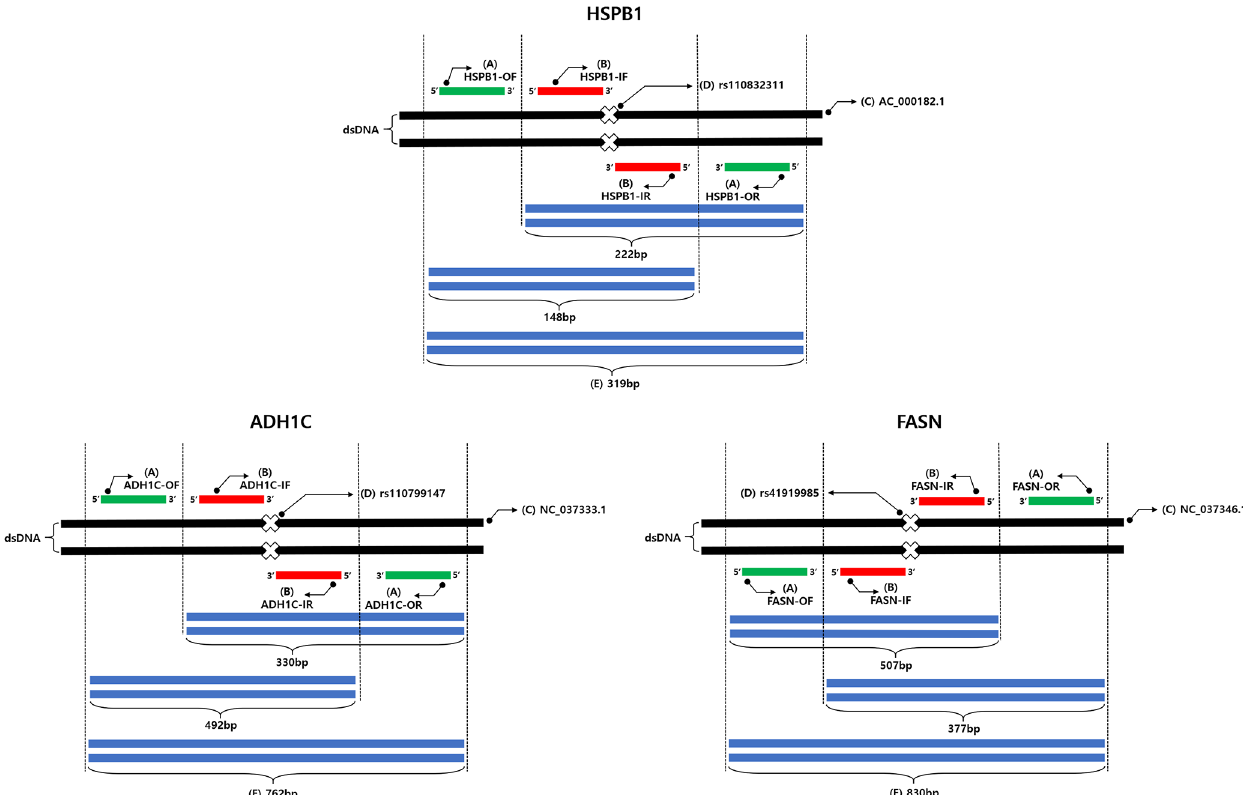
Figure 1. Schematic diagram of AS-PCR amplification and size of fragments. (A) Outer primers are indicated by green rectangles. (B) Inner primers are indicated by red rectangles. (C) DNA sequences were retrieved from NCBI using their accession numbers. (D) The rs numbers of SNPs are indicated by cross marks, and the amplified size of each SNP genotype is indicated by blue rectangles. (E) Amplicon of positive